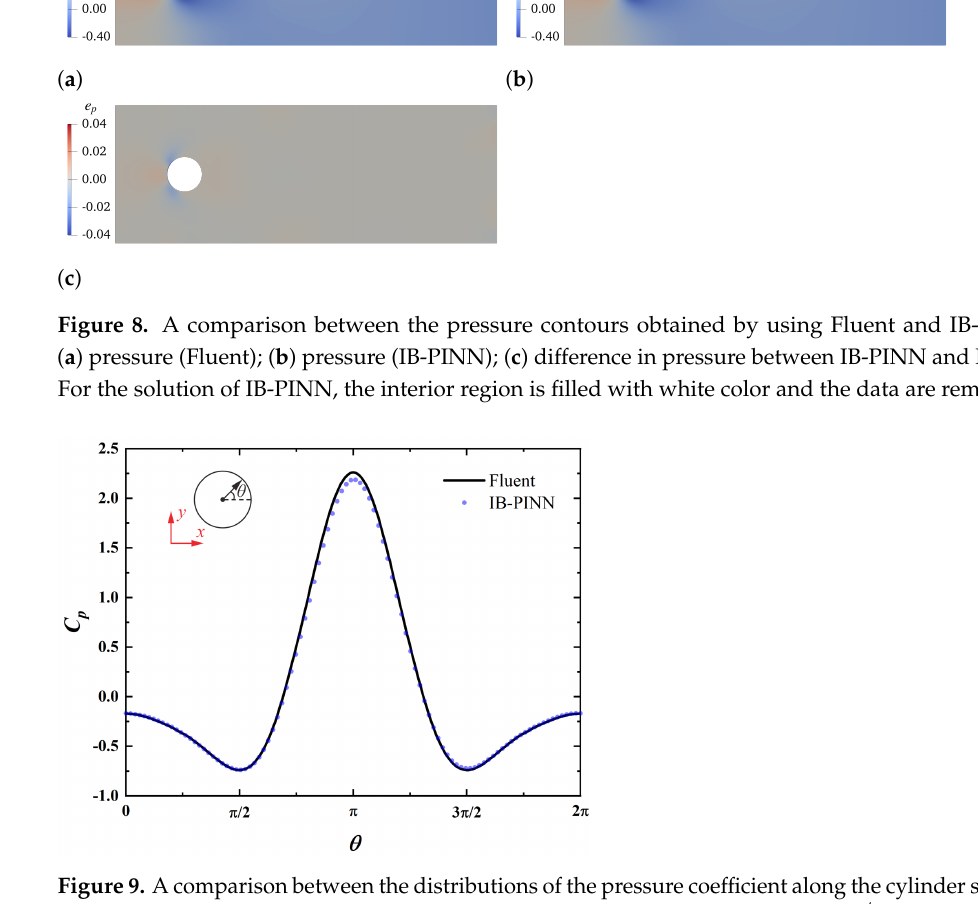
(cid:46) ( 1 ρ U 2 max ) , where 2